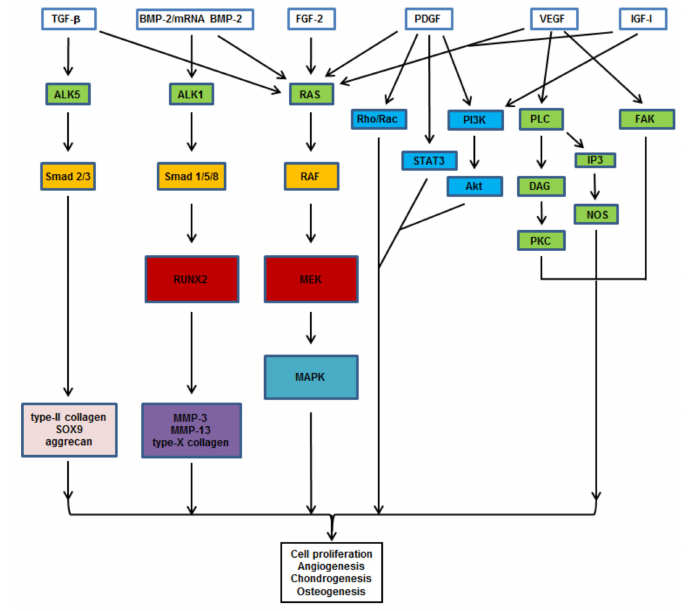
Figure 2. Signaling pathways triggered by therapeutic candidates for osteochondral repair. TGF- β promotes chondrogenesis by activating the PI3K, Smad 2 / 3, and RhoA pathways. FGF-2, BMP-2, and mRNA BMP-2 induce osteo- / chondrogenesis via the RAS / RAF / MEK / MAPK and Smad pathways. PDGF activates angiogenesis via crosstalks between the MAPK, Rho / Rac, STAT3, and PI3K pathways. IGF-I induces the MAPK and PI3K pathways. VEGF induces angiogenesis by activating the PLC, IP3, and FAK pathways. Abbreviations: TGF- β : transforming growth factor beta; BMP-2: bone morphogenetic protein 2; mRNA: messenger ribonucleic acid; FGF-2: basic fibroblast growth